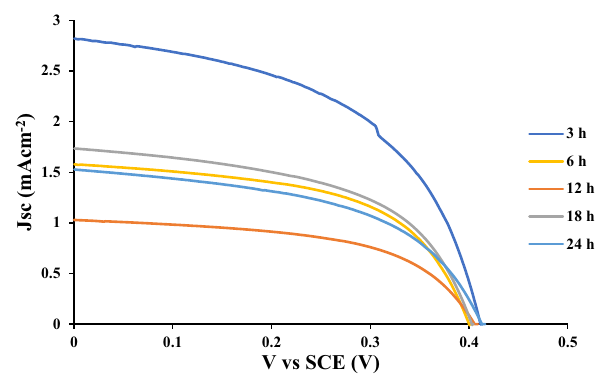
Fig. 4 I – V curves of DSSC cells sensitized with 4a at different times of